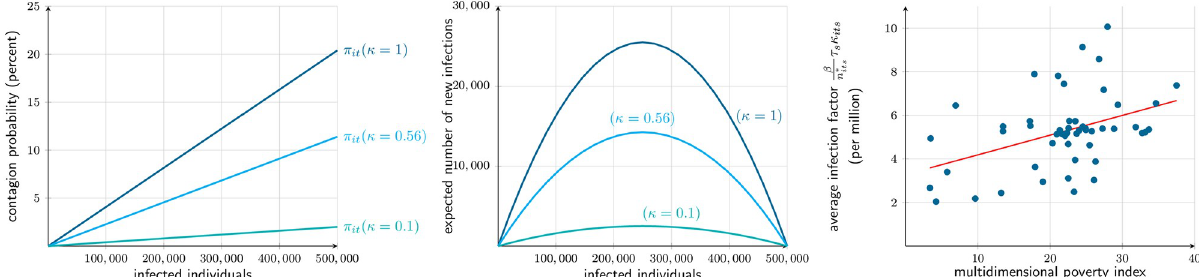
Fig 8. Estimated contagion probability in a municipality with 500,000 people present. (a) Daily contagion probability as a function of the number of infected individuals and the confinement degree. (b) Daily expected contagion flow as a function of the number of infected individuals and the confinement degree. (c) Estimated average infection factor for the residents of each municipality in the SMR at any labor business-day segment in the first two weeks of March, 2020, and multidimensional poverty index.